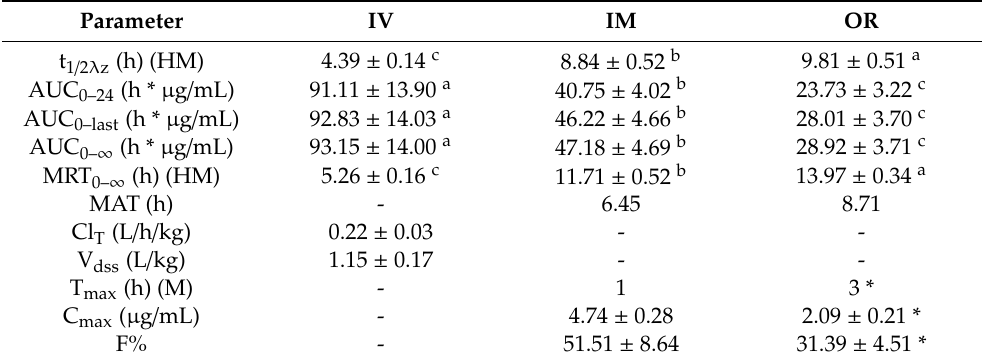
Figure 1. Semi-logarithmic plasma concentration – time curves of doxycycline hyclate following intravenous (IV), intramuscular (IM) and oral administrations at a dose of 20 mg/kg in goats ( n = 6, mean ± SD). Table 1. Plasma pharmacokinetic parameters of doxycycline hyclate following intravenous (IV), intramuscular (IM) and oral (OR) administrations at a dose of 20 mg / kg in goats ( n = 6, mean ± SD).